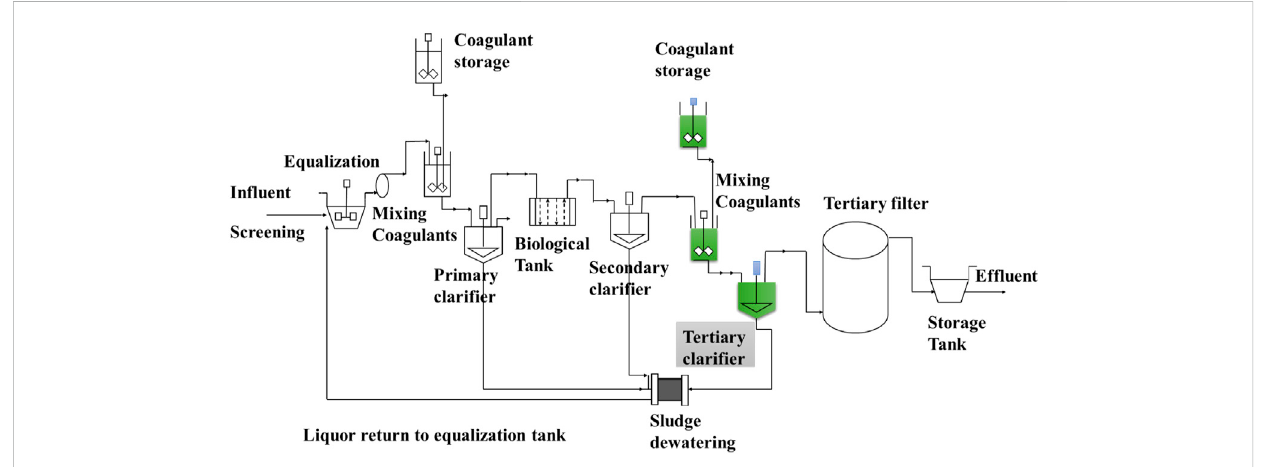
FIGURE 3 Proposed and recommended fl ow process for textile industry wastewater treatment